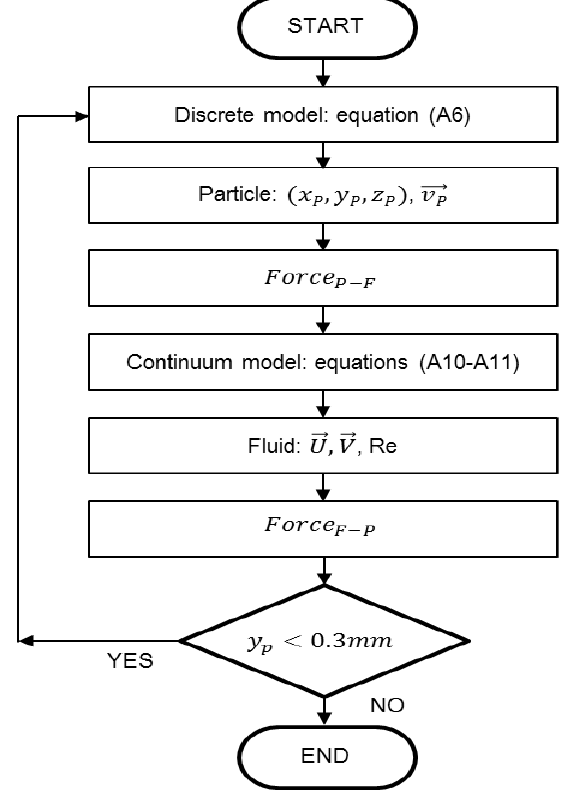
Figure A2 Flow chart of